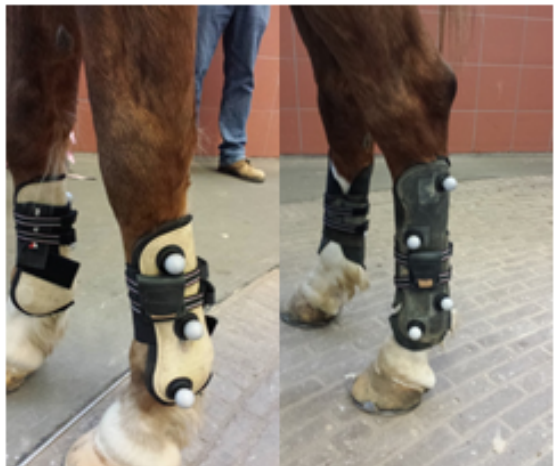
Figure 9. Placement of the IMU sensors and optical motion capture markers on fore- and